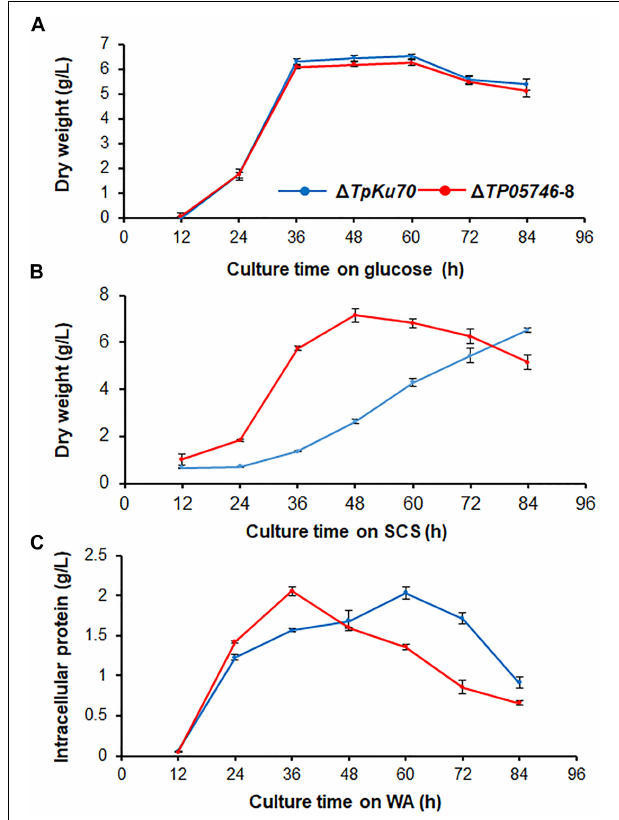
FIGURE 4 | Growth curves of T. pinophilus mutant (cid:49) TP05746 and the parental strain (cid:49) TpKu70 in SLM containing glucose (A) , SCS (B) , or WA (C) as the sole carbon source for 12–84 h at 28 ◦ C, respectively. Three independent experiments were performed as biological replicates. SLM, standard liquid medium; SCS, soluble corn starch; WA, wheat bran plus